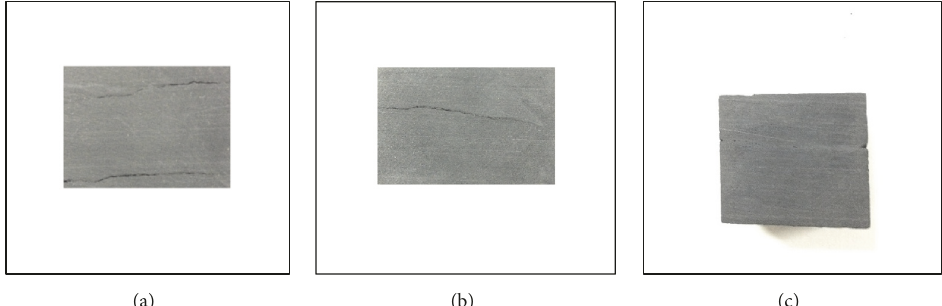
Figure 3: Shale samples of Case 3. (a) Sample with significant fractures. (b) Sample with limited fractures: the volume is the same as that of the sample shown in (a). (c) Sample with limited fractures: the volume is smaller than that of the sample shown in (a) and (b).